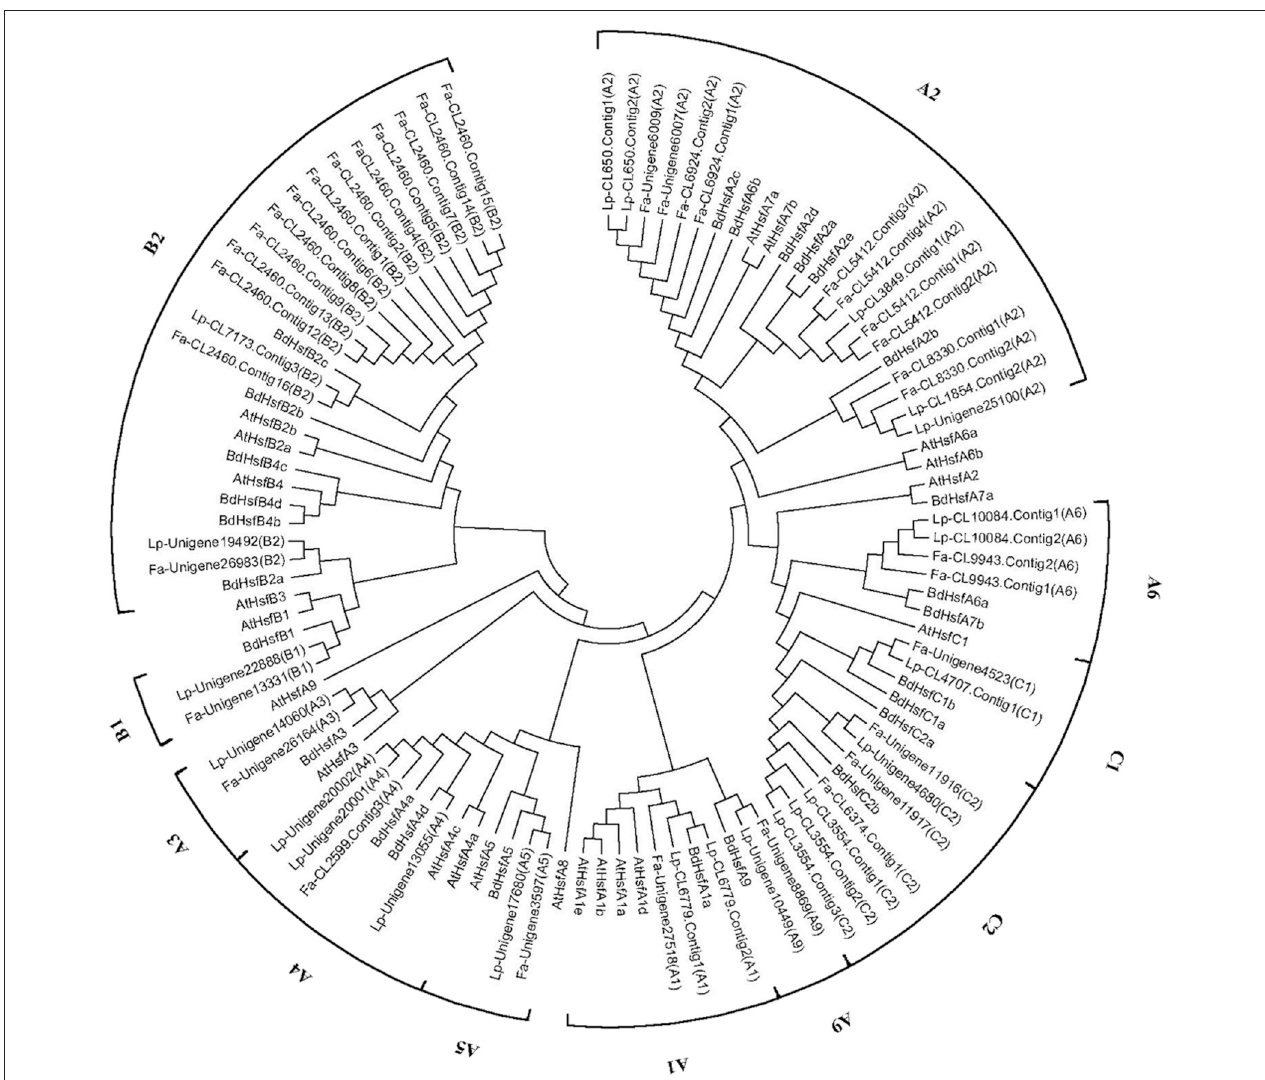
FIGURE 2 | Neighbor–joining phylogenetic tree of Hsf proteins from the tall fescue, perennial ryegrass, Brachypodium distachyon , and Arabidopsis thaliana . Hsfs in Brachypodium distachyon are prefixed by Bd, and Hsfs in Arabidopsis thaliana are prefixed by At. Hsfs in tall fescue are marked by a “Fa” prefix and sequence-ID in the transcriptome. Hsfs in perennial ryegrass are marked by a “Lp” prefix and a sequence-ID in the